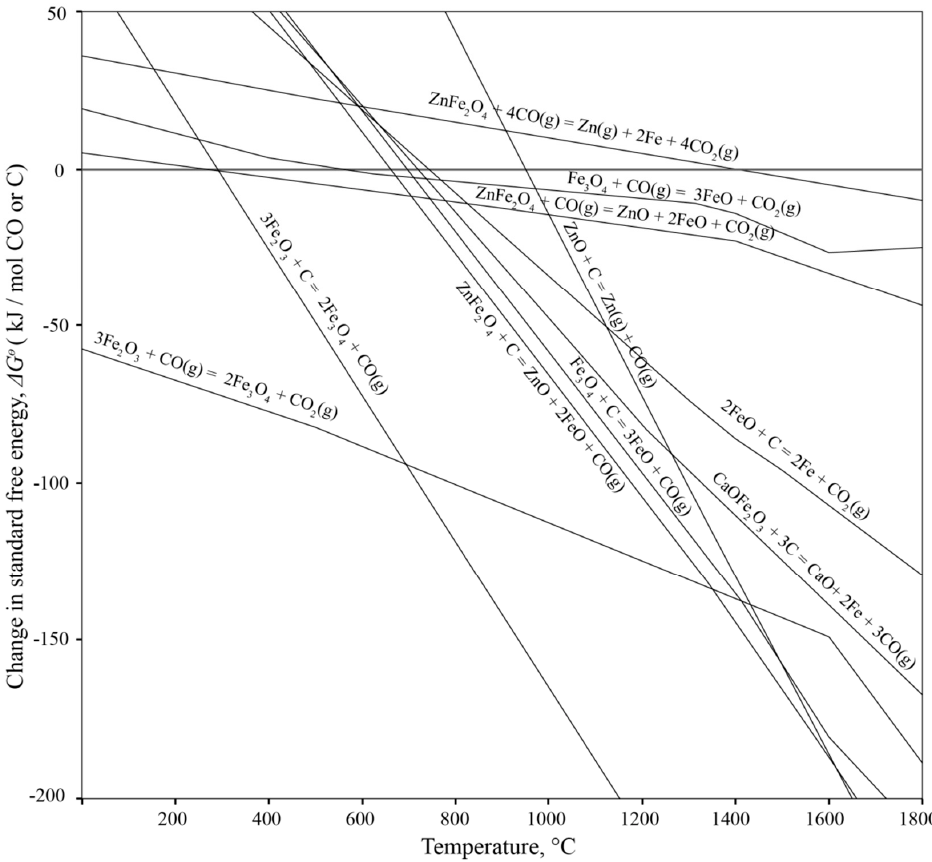
Figure 3. The Gibbs free energy changes for the related reactions.